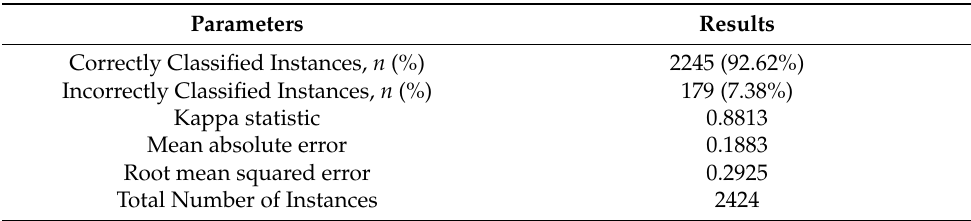
Table 4. Summary results.